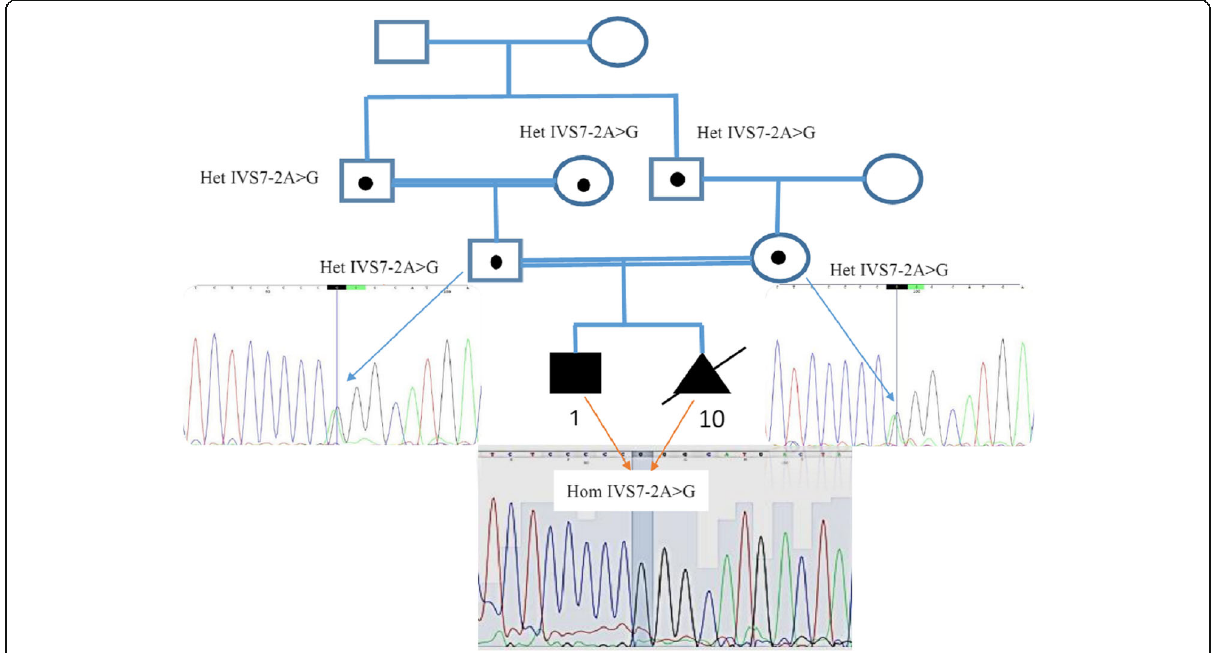
Fig. 1 Pedigree and Sanger sequencing details. Using Sanger sequencing, the inheritance mode of autosomal recessive was confirmed in this family based on identified homozygote mutation in the proband and heterozygote mutation in his parents and three of his grandparents. Here only sequencing graph from the proband and his parents are given. Het: Heterozygous. Hom: